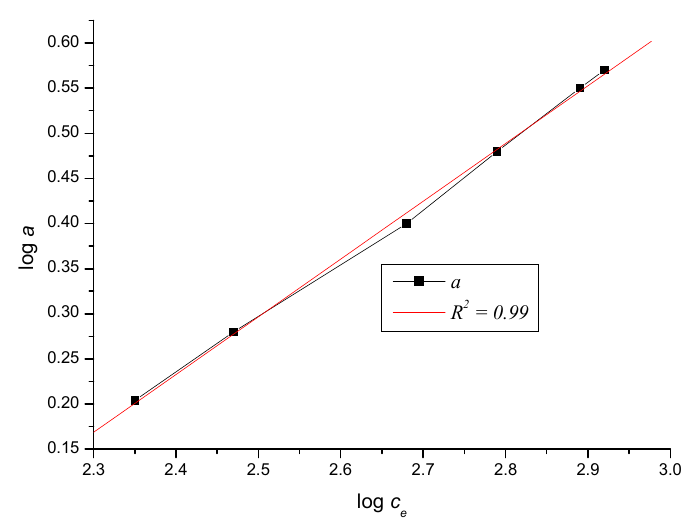
Figure 9. Linearization of the Freundlich isotherm for adsorption and equilibrium concentration values.